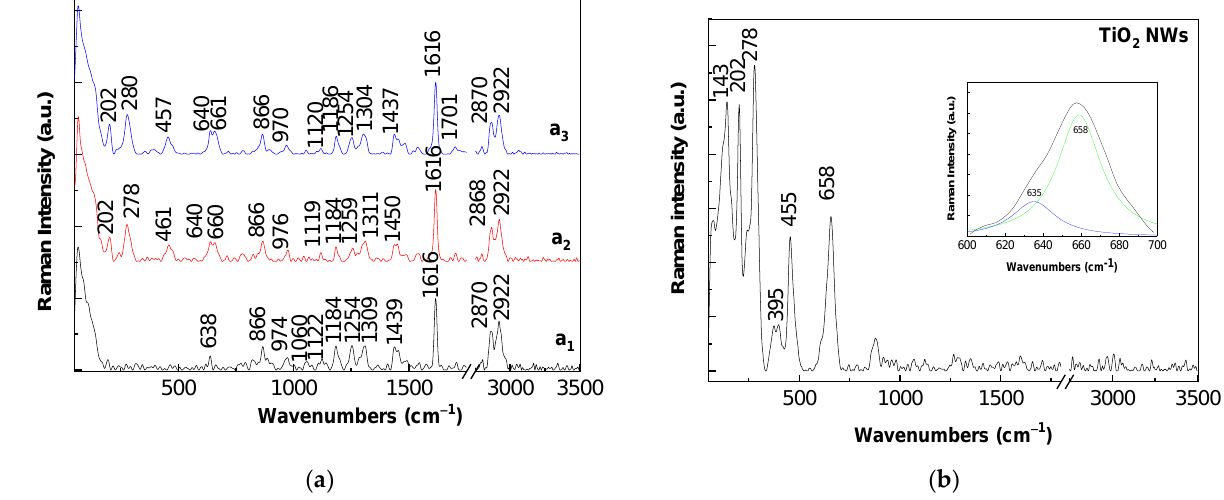
Figure 6. Raman spectra of: ( a ) TPU ( a 1 ); TPU – TiO 2 NW composites have TiO 2 NW concentrations equal to 2 wt.% ( a 2 ) and 17 wt.% ( a 3 ); and ( b ) TiO 2 NWs.